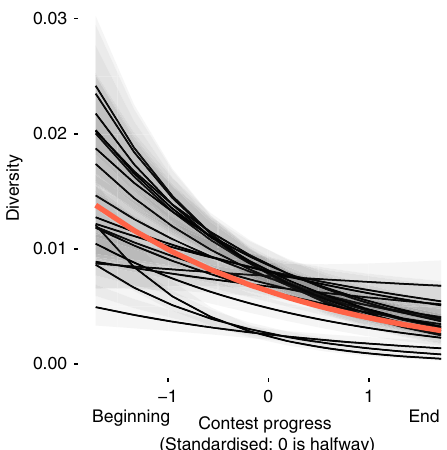
Fig. 4 Cultural diversity decreased over time. Generalised linear mixed- model predictions of cultural diversity over time. Each black line plots the predictions for a single contest, whilst the red line plots the overall estimate. The shaded area indicates the 95% credible interval of the posterior estimates per contest ( n = 1845 data points binned by time, see